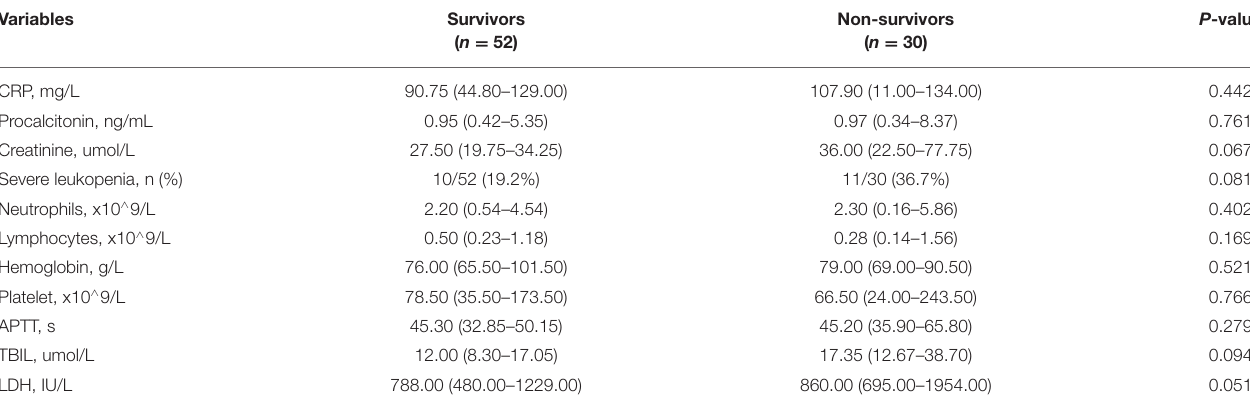
TABLE 2 | Comparison of laboratory results between the survivor and non-survivor groups. Variables